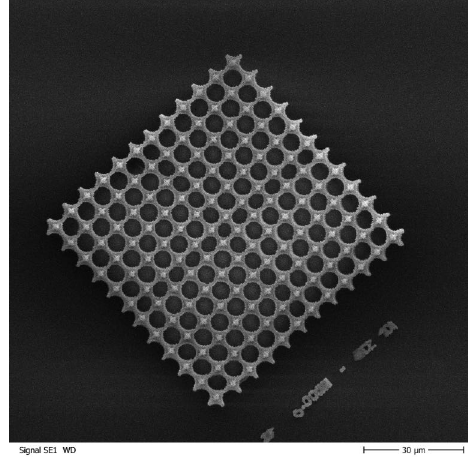
Figure 4. Structure developed with acetone